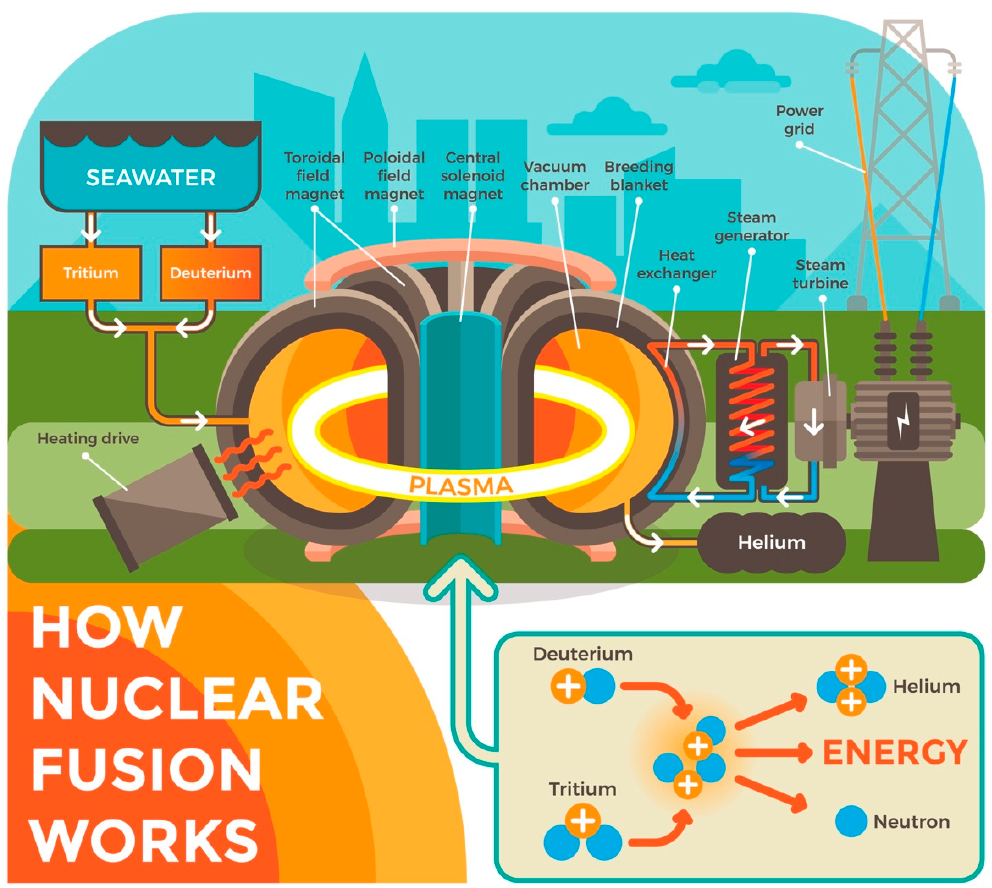
Figure 12. Schematic representation of thermonuclear fusion. The arrows indicate the directions of the flow of media in the form of sea water and the deuterium and tritium ions produced on its basis, starting from the water reservoir and ending with the fusion reactor. Reproduced with permission from [125], e-magazyny.pl, 2022.